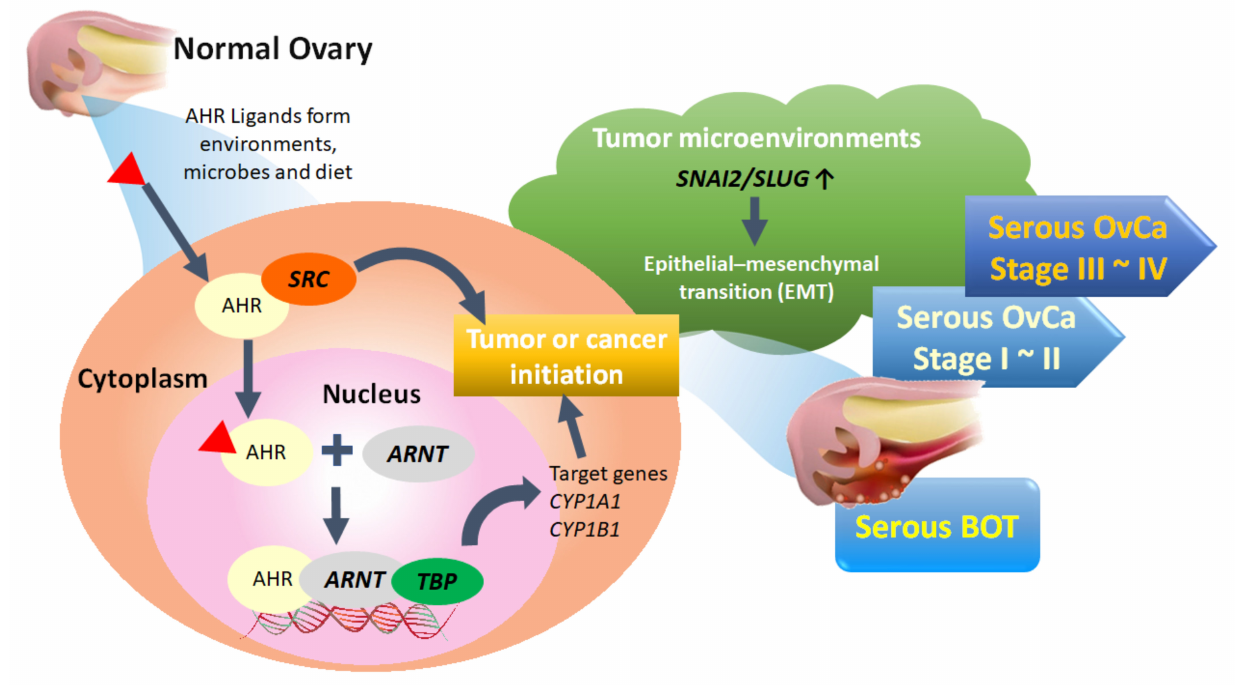
Figure 5. Proposed pathogenetic mechanism of the AHR binding pathway combined with EMT-related factors for tumori- genesis of serous ovarian tumors. BOT: borderline ovarian tumor; OvCa: ovarian